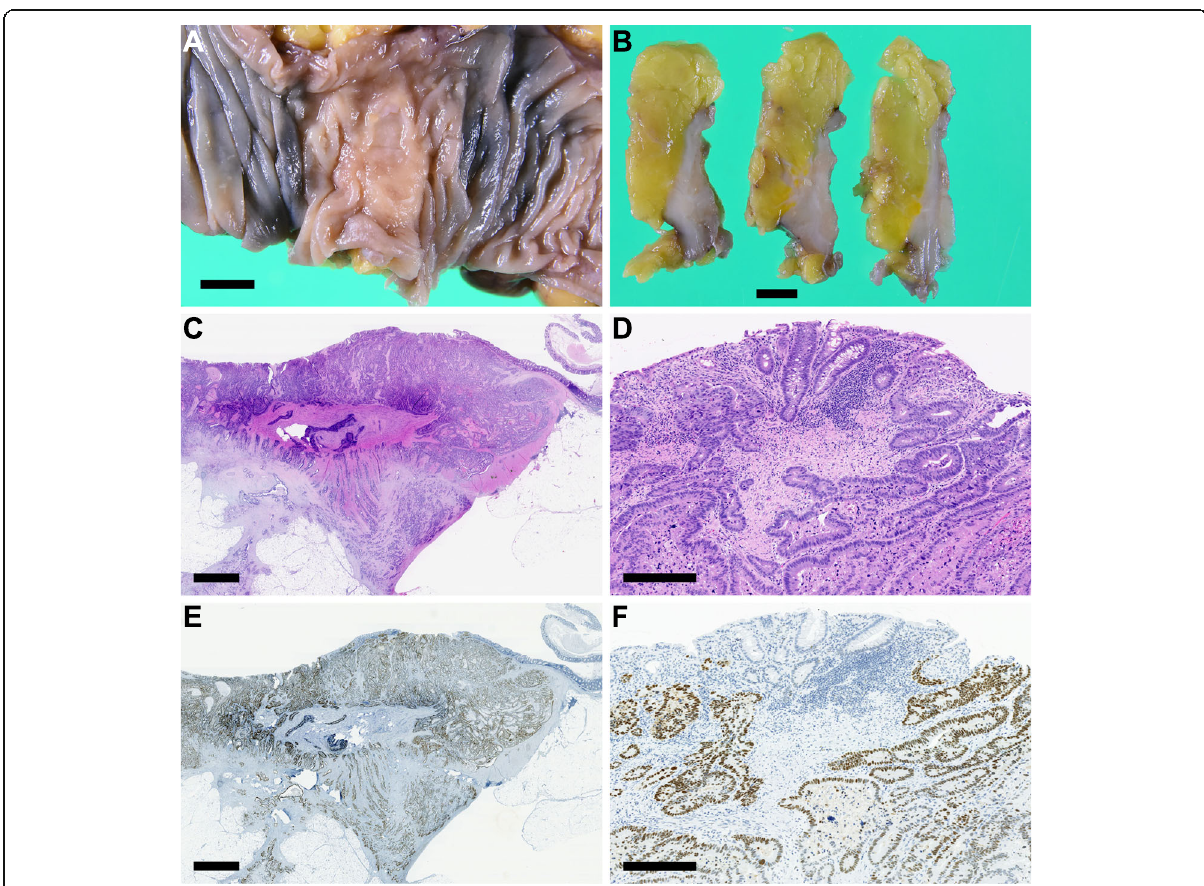
Fig. 5 Image of a previous colon cancer. a Surface and b slices of the tumor. c Representative whole-slide and d magnified hematoxylin and eosin staining images of the tumor. e Representative whole-slide and f magnified images of p53 immunostaining. Black bars: 1 cm ( a , b ), 2.5 mm ( c , e ), 250 μ m ( d , f